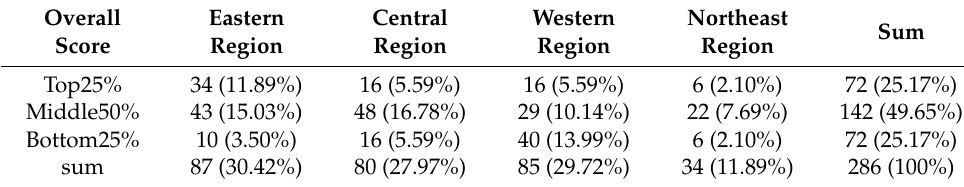
Table 4. Overall score of